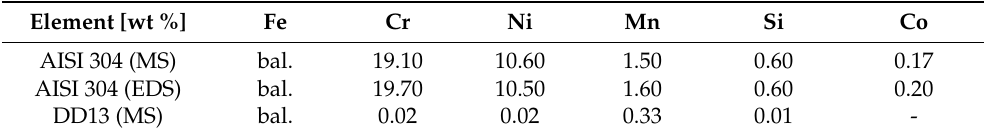
Table 1. Chemical composition of the substrate steel DD13 and powder AISI 304 (MS—manufacturer specification, EDS—receiving inspection by means of scanning electron microscopy with energy- dispersive X-ray spectroscopy). Element [wt